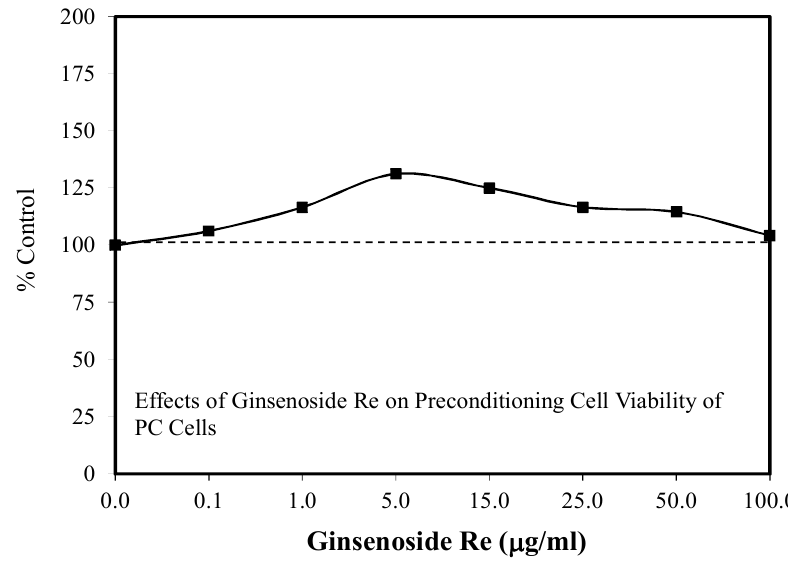
Figure 40. E ff ects of ginsenoside Re on preconditioning cell viability of PC cells (source: Figure 40. Effects of ginsenoside Re on preconditioning cell viability of PC cells (source: [52]).